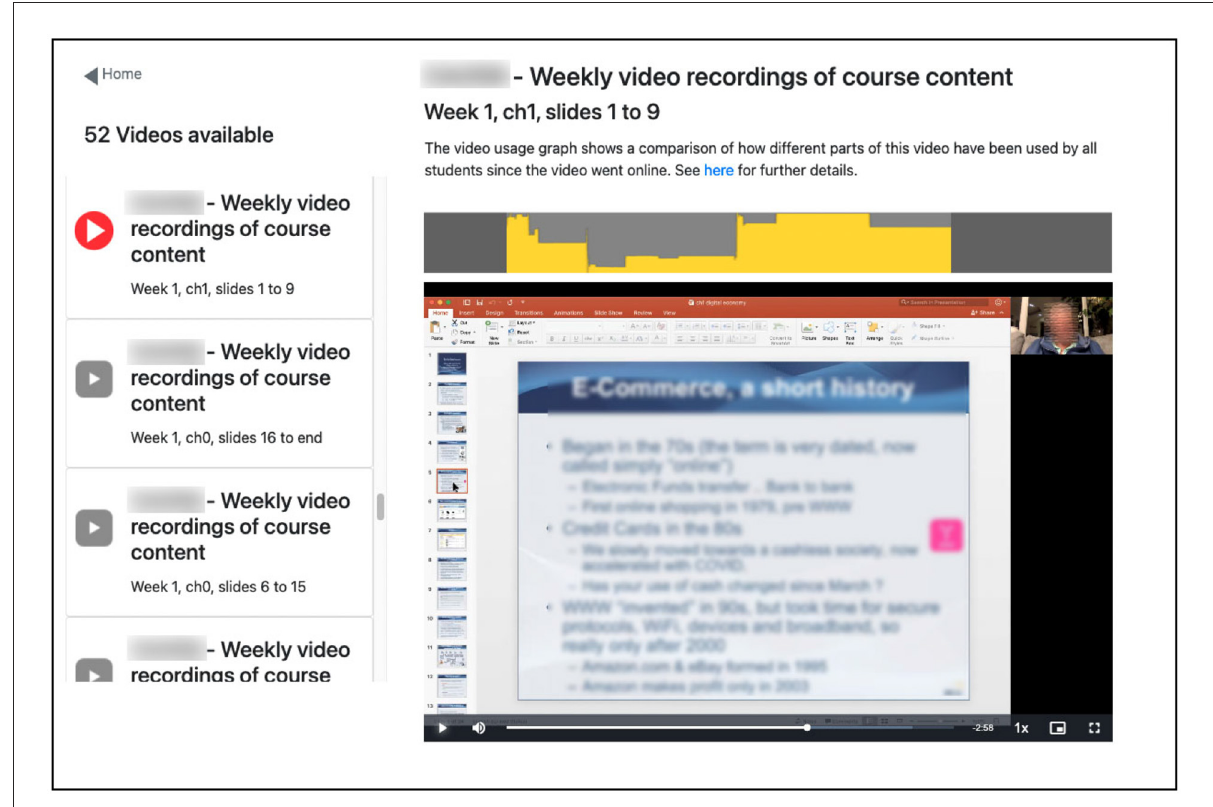
FIGURE2 Screenshot of system interface showing the user has 2:58 left to play at 1x speed of what appears as a 10 min video from week 1, chapter 1, slides 1–9 of the course. The yellow graph just above the video playback panel indicates the section the student is about to play has had highest usage scores based on previous video playback from the class whereas the part of the video at about the 1/5 mark has low